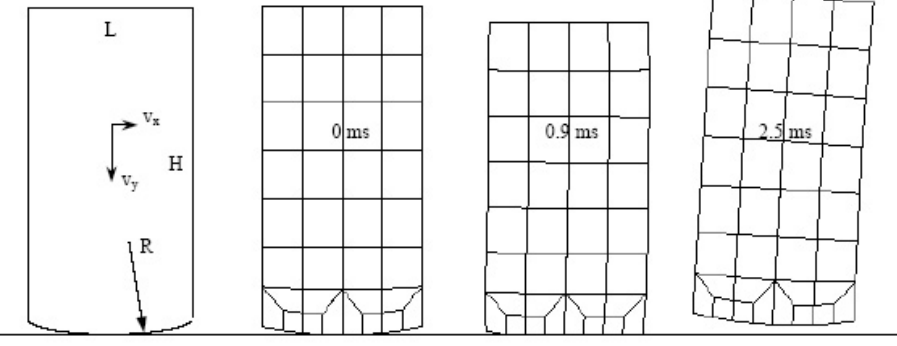
Fig. 1. Oblique impact of an elastic plate: geometry and deformed shapes vs. time.